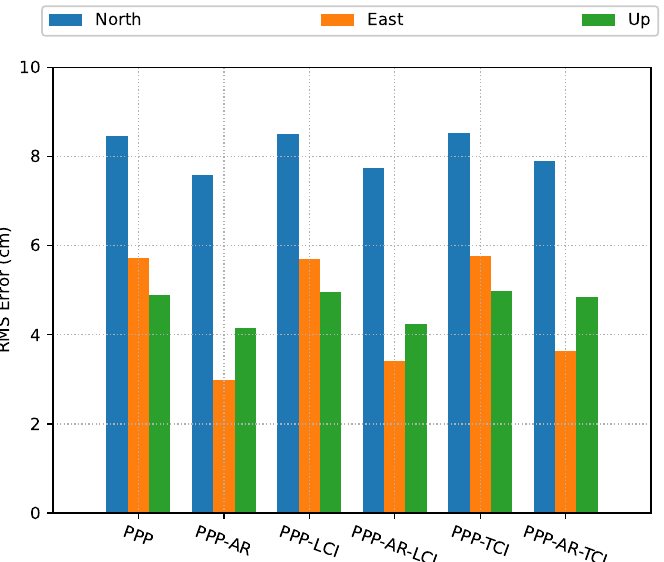
Figure 9. PPP/INS positioning error RMS of the train test on 7 March 2022 with respect to IE RTK solutions.